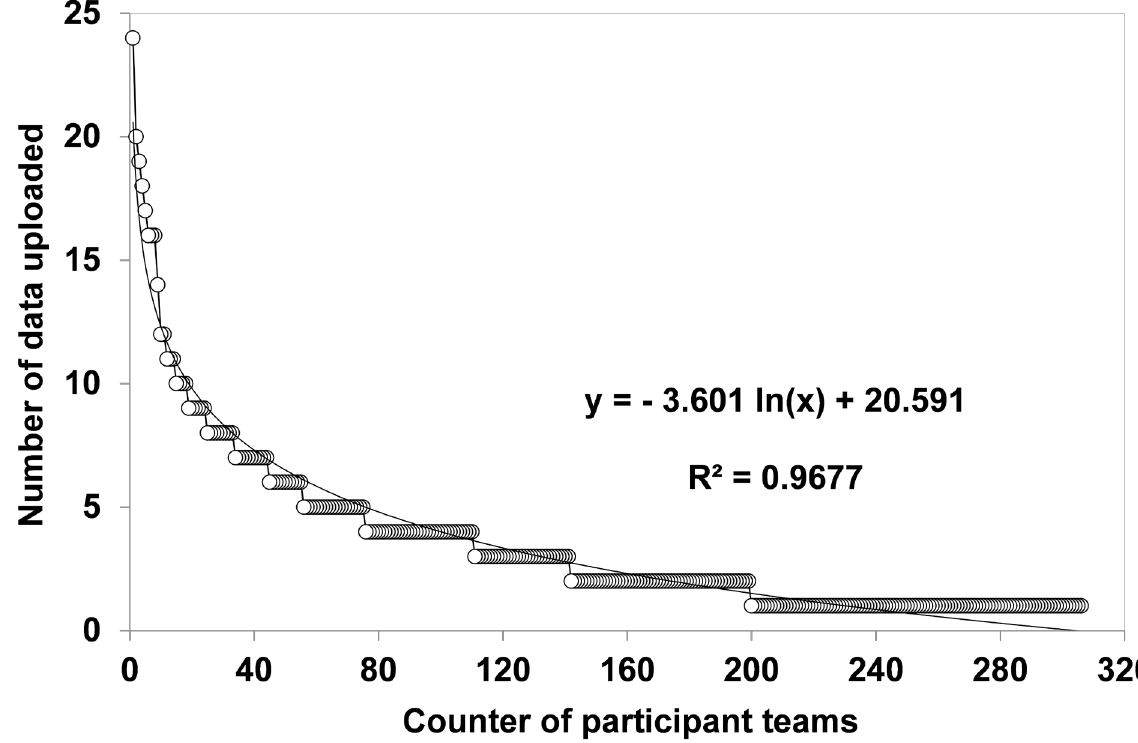
Figure 8 - Datasets acquired by each volunteers of the Adopt a River project up to January 2015 (excluding datasets obtained by the University of São Paulo and Earthwatch